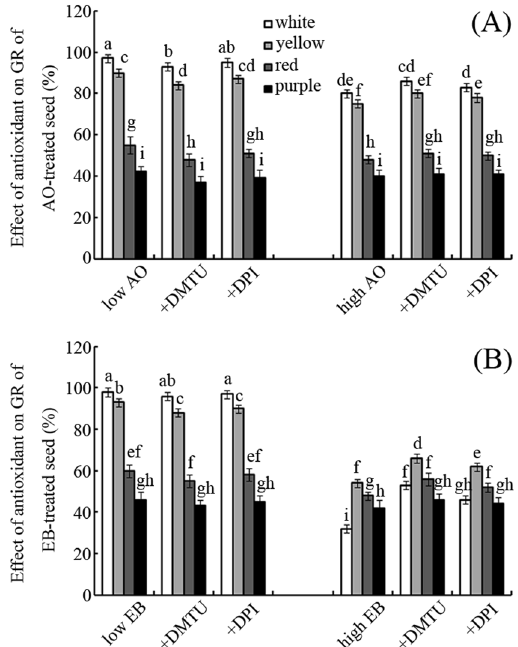
Figure 5. Effects of DMTU and DPI on GR Effects of DMTU and DPI on the GRs of maize seeds treated with low (left) or high (right) concentrations of AO ( A ) or EB ( B ). Bars represent standard deviations of means ( n = 5); means followed by the same letter are not significantly different ( p < 0.05) among treatments. Low (0.5 mg ml − 1 for AO, 50 μ g ml − 1 for EB) or high (5 mg ml − 1 for AO, 500 μ g ml − 1 for EB) concentrations of AO/EB represent controls. DMTU, dimethyl thiourea; DPI, diphenylene iodonium; AO, acridine orange; EB, ethidium bromide; GR, germination rate.